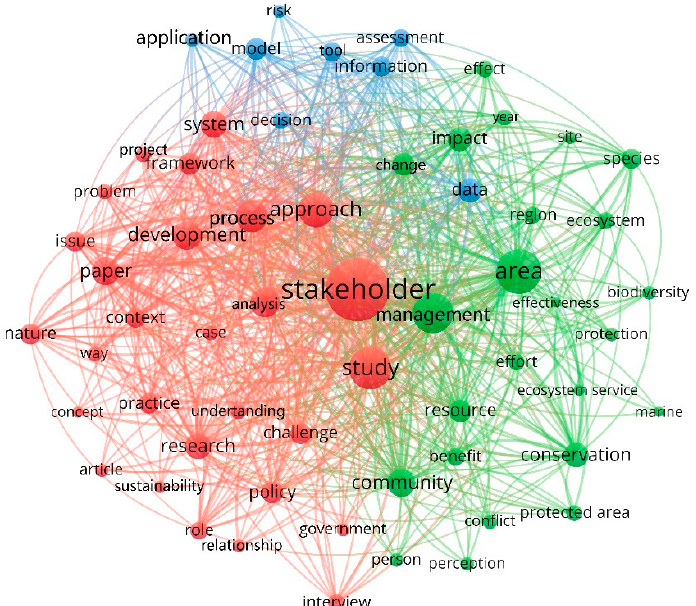
Figure 1. Co-occurrence network map of keywords in the global scientific literature on NPAs and stakeholders. The size of each keyword (node) in the network is directly proportional to its number of occurrences in the documents analyzed. Colors indicate clusters to which keywords are univocally assigned based on their reciprocal relatedness.